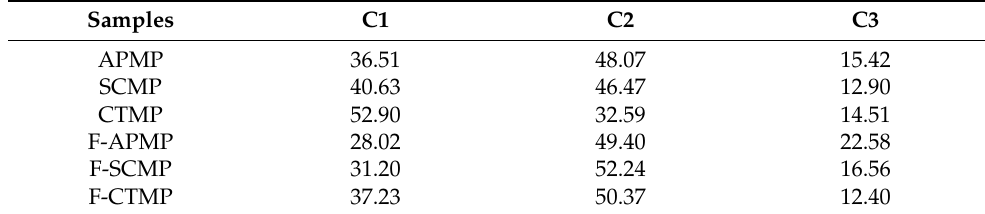
Table 4. Element composition of the C1s peak of the pulp.